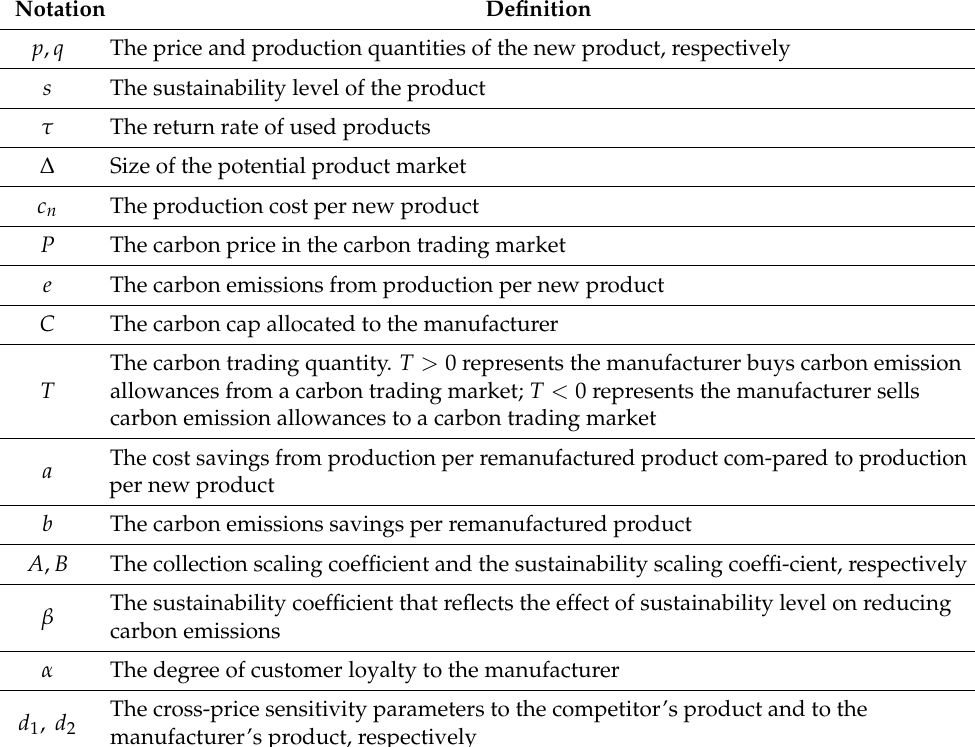
Table 1. List of